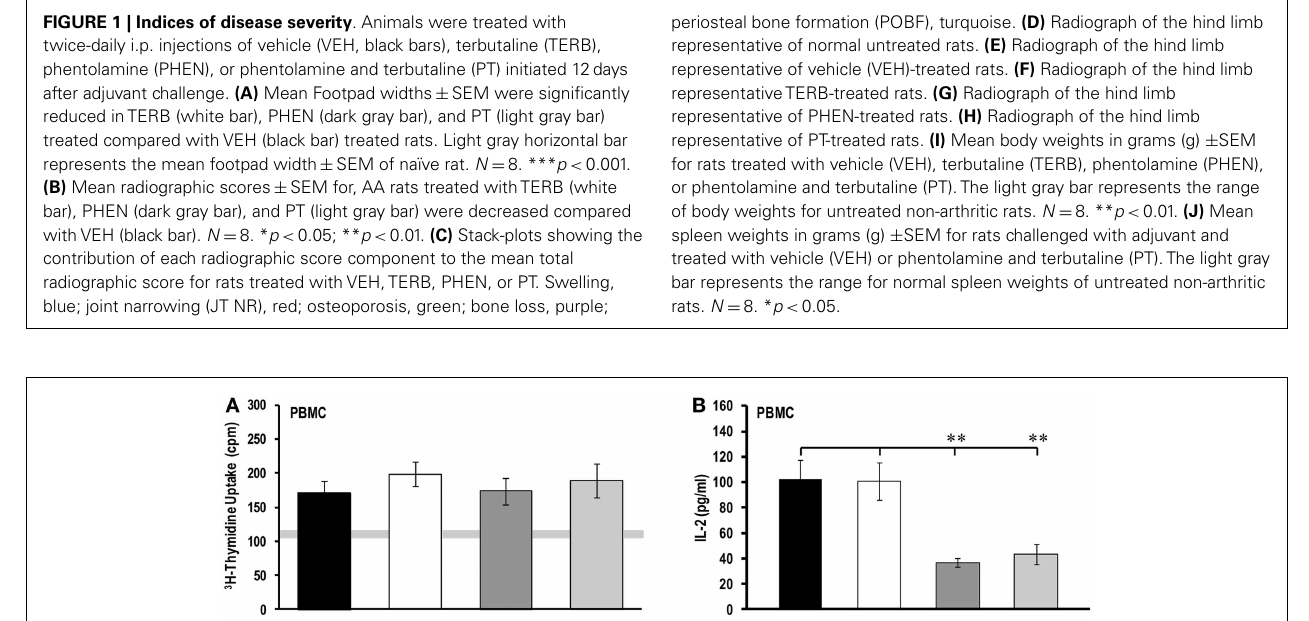
FIGURE 2 | Proliferative response and IL-2 production in peripheral blood mononuclear cells (PBMC) . Animals were treated with twice-daily i.p. injections of vehicle (VEH, black bars), terbutaline (TERB, white bars), phentolamine (PHEN, dark gray bars), or phentolamine and terbutaline (PT, light gray bars) initiated 12days after adjuvant challenge. (A) Proliferative